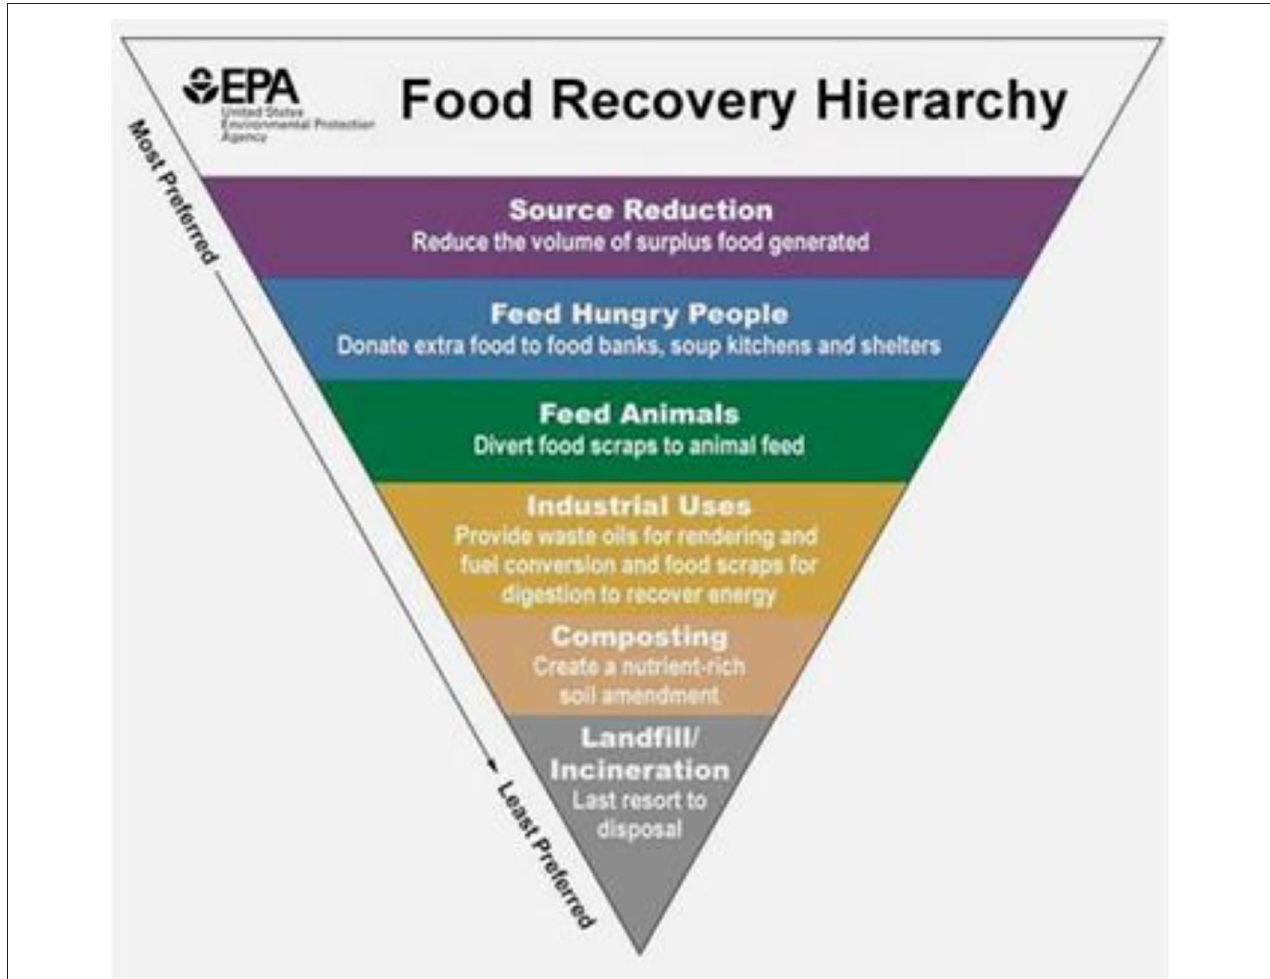
FIGURE 1 | United States Environmental Protection Agency (US-EPA) food recovery